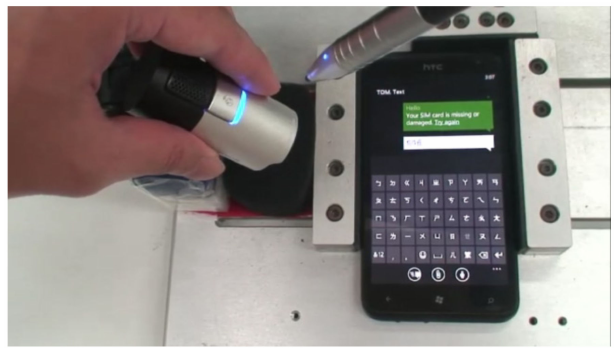
Figure 20. After moving the